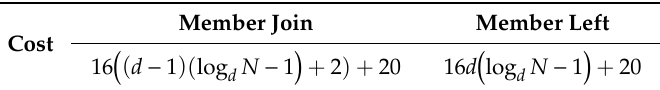
Table 3. CEGKD communication